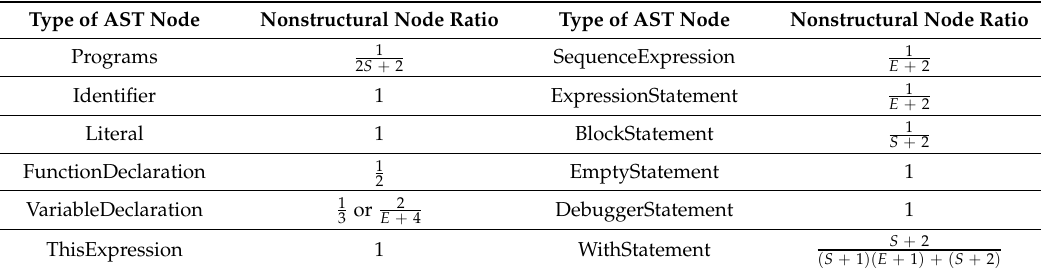
Table 1. Minimum node reduction rate of each AST node